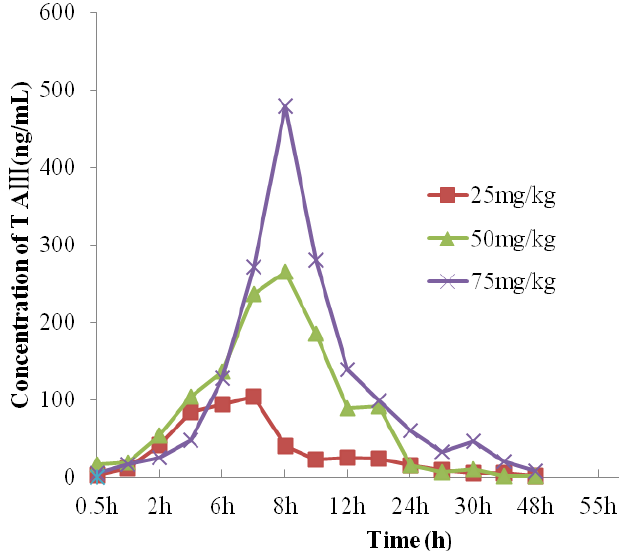
Figure 5. Plasma concentration-time curves of TA-III after intragastric administration to rats at dose of 25, 50 and 75 mg/kg.